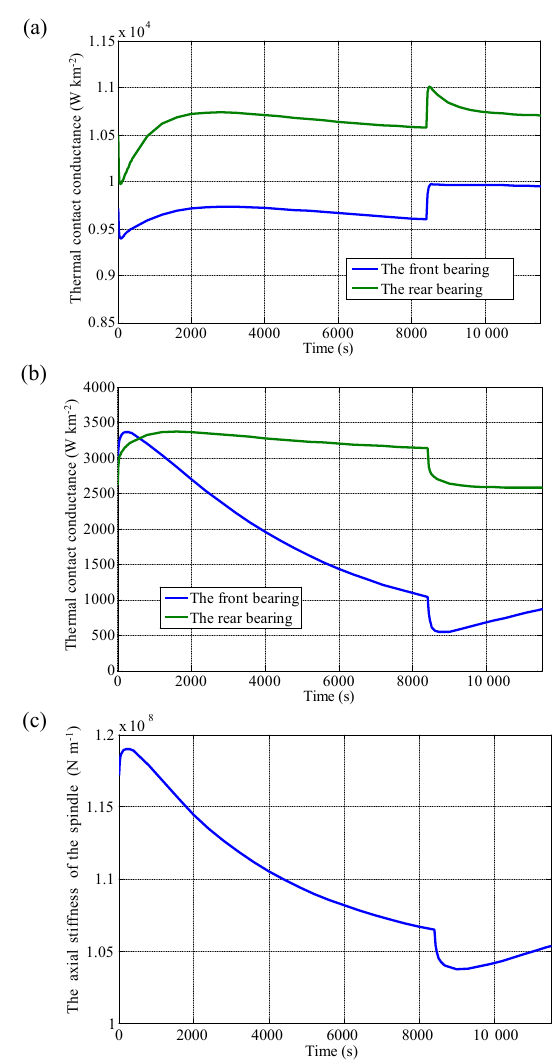
Figure 11. Thermal characteristics of the proposed model. (a) TCCs between inner race and shaft. (b) TCCs between outer race and housing/hydraulic cylinder. (c) Axial stiffness of bearings in